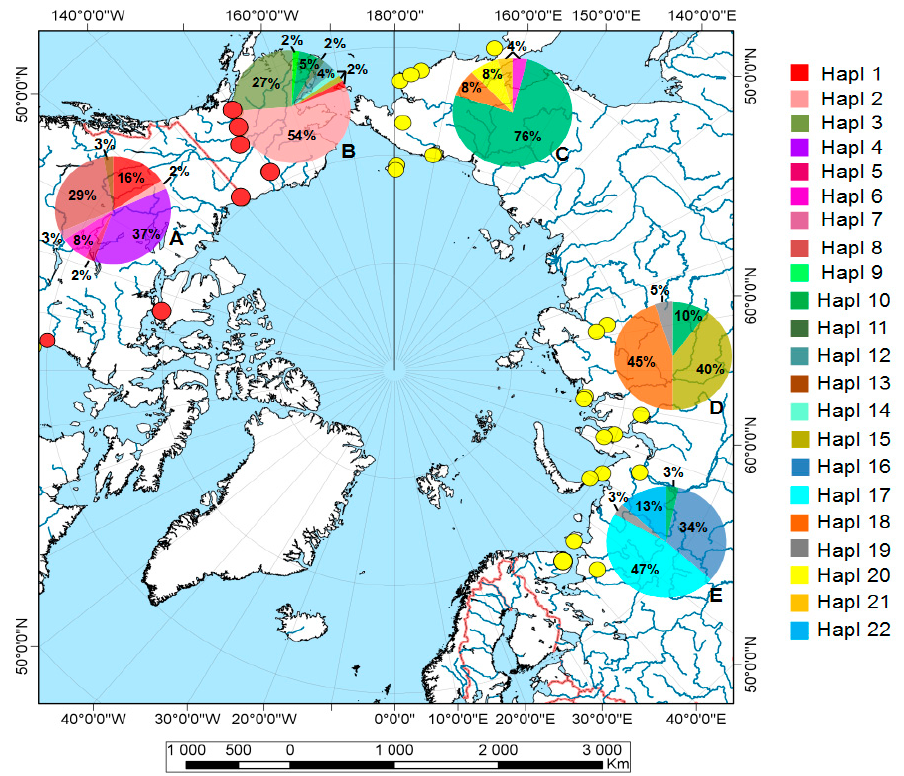
Figure 1. Map showing the location (dots) of Pterostichus brevicornis brevicornis samples (for details see Supplementary Materials Tables S1 and S3) and the respective mtDNA haplotype distribution (pie charts) per population: A—North Canada, B—Alaska, C—Northeast Asia, D—West and Central Siberia, E—North Europe. A unique COI haplotype from Kamchatka (Hapl 23) is not shown. Yellow dots—data from this study (genetic data and specimens for shape analysis); red dots—DNA sequences from NCBI GenBank.